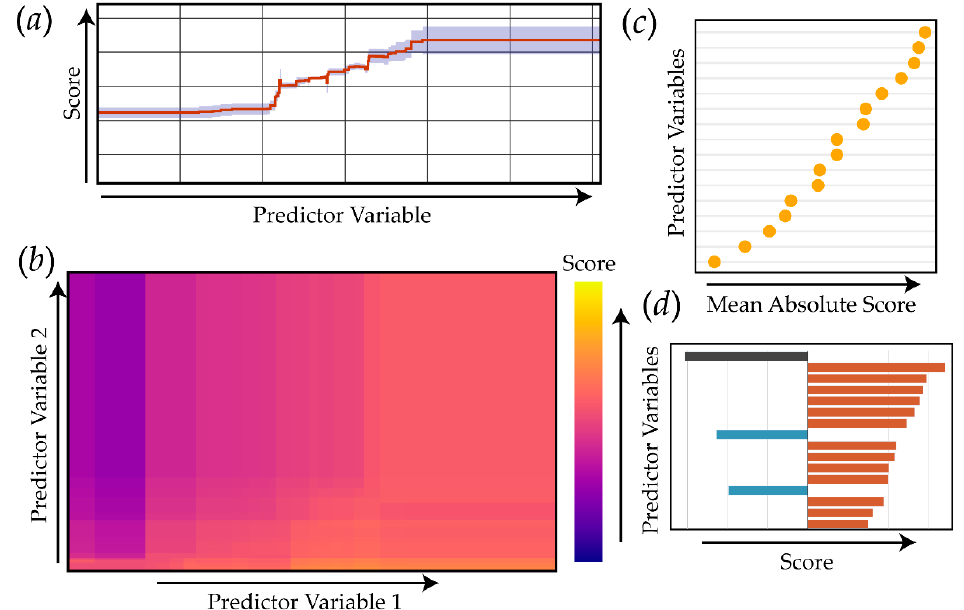
Figure 1. Conceptualization of outputs from EBM that provide model explanations. ( a ) One-dimensional feature function for a single predictor variable; ( b ) two-dimensional function for interaction between two predictor variables; ( c ) global estimate of variable importance as mean absolute score; ( d ) contribution scores for variables for predicting a new sample. Arrows indicate direction of increasing values. Scores relate to the effect of each included predictor variable or interaction on the predicted logits for the positive class.